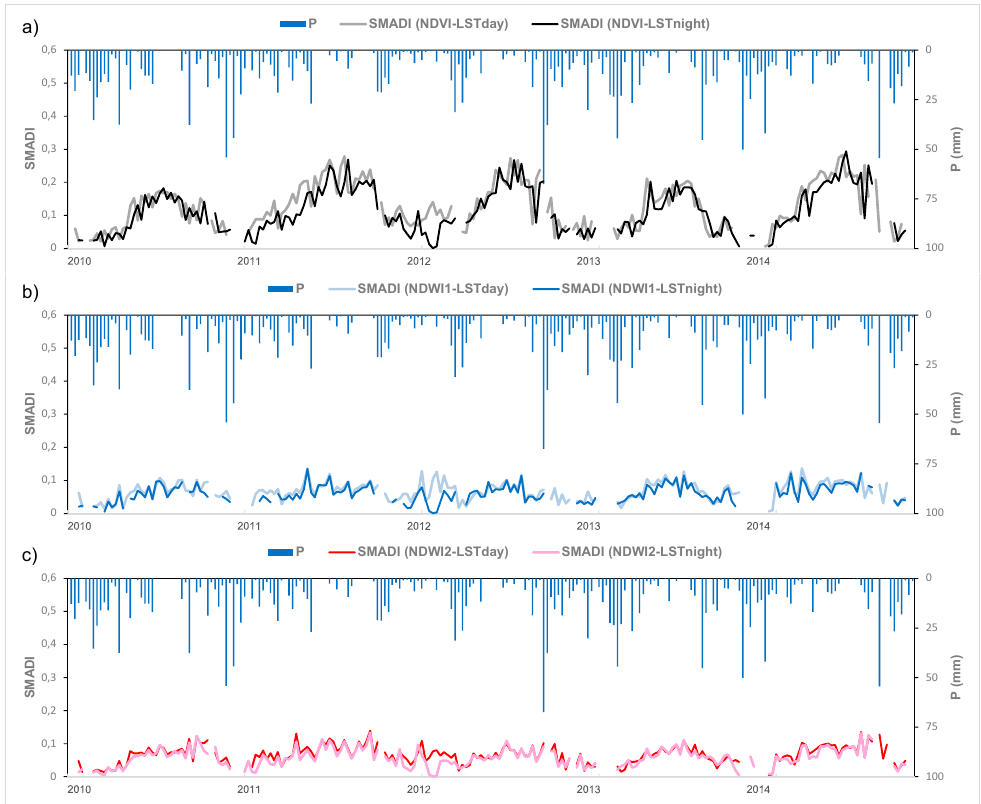
Figure 3. Cont. Figure 3.